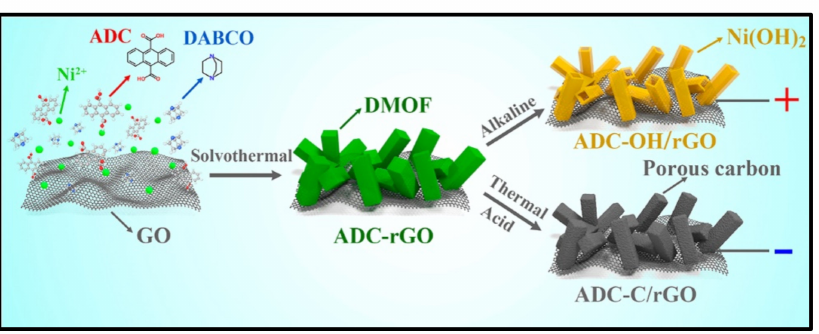
Figure 1. Synthesis procedures for ADC-rGO, ADC-OH/rGO, and ADC-C/rGO [17]. Reprinted with permission from Yang Jiao, Chong Qu, Bote Zhao, et al. High-Performance Electrodes for a Hybrid Supercapacitor Derived from a Metal-Organic Framework/Graphene Composite. ACS Appl. Energy Mater. 2019, 2, 5029–5038. Copyright (2019) American Chemical